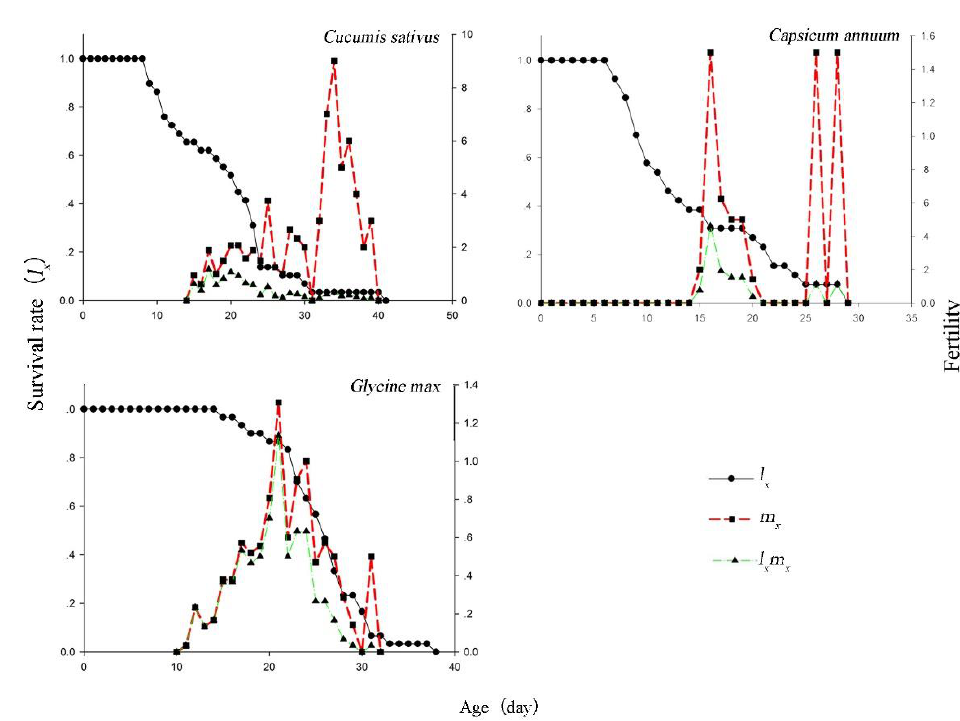
Figure 3. Age-specific survival rate ( l x ), age-specific fecundity ( m x ), and age-specific maternity ( l x m x ) of Thrips flavus on different plants.